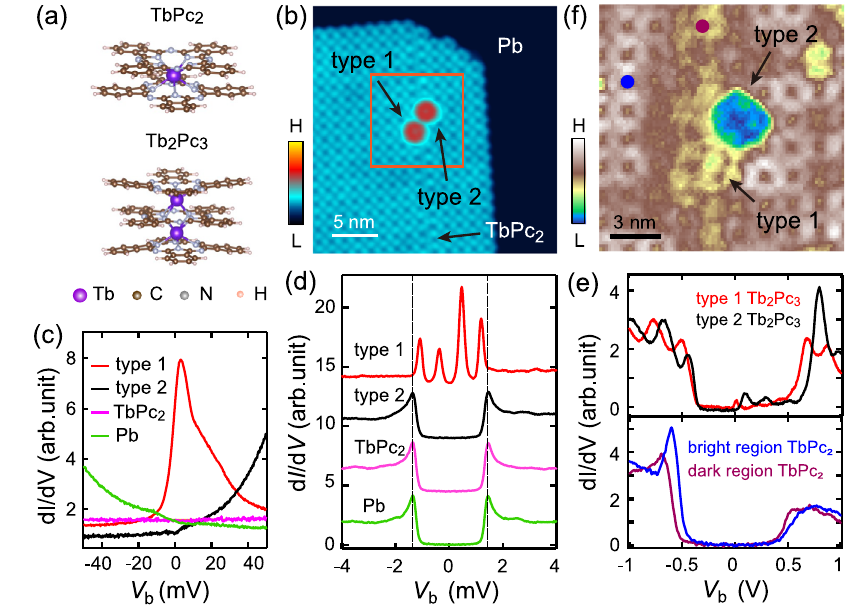
Fig. 1 | Sample morphology and molecular spin states. a Molecular structure of substrate, TbPc 2 and the two types of Tb 2 Pc 3 . The dashedlines mark the energy of TbPc 2 and Tb 2 Pc 3 . b STM topography ( V = − 1.0V and I =10 pA) of TbPc 2 molecular the superconducting coherence peaks. e Tunneling spectra ( V =1.0V and I =100 V =50mV, I =100pA) of fi lm with imbedded Tb pA) showing electronic structure of Tb 2 Pc 3 and TbPc 2 at different moiré regions. 2 Pc 3 on Pb. c Tunneling spectra ( f d I /d V mapping ( V =615mV, I =100 pA) of the rectangle area in ( b Tb 2 Pc 3 under2T. d High-energyresolutionspectra( V =10mVand I =100pA)ofPb